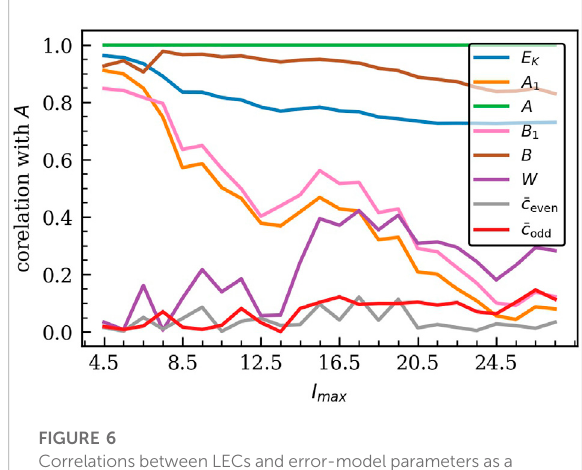
FIGURE 6 Correlations between LECs and error-model parameters as a function of I max , resulting from the analysis on the lowest K =1/2 rotational band in 239 Pu at N 4 LO with k max =10.